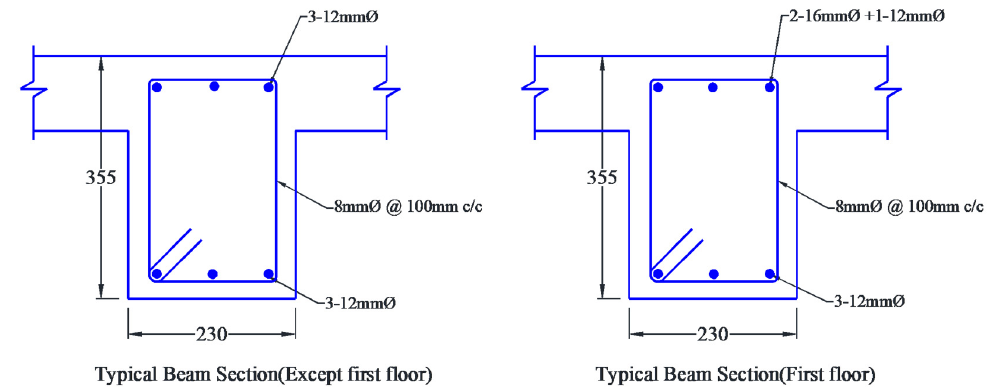
Figure 2. Geometrical and reinforcement details of RC beam section.